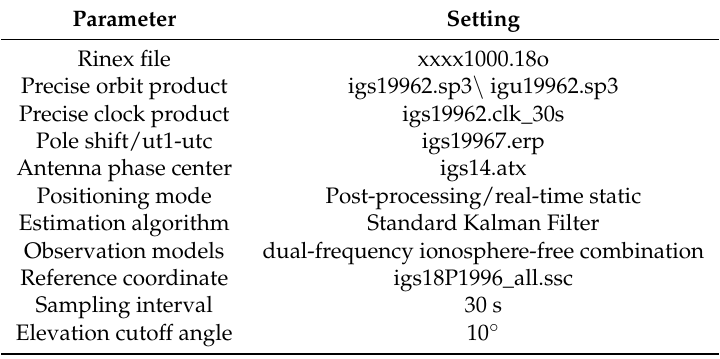
Table 2. General parameter